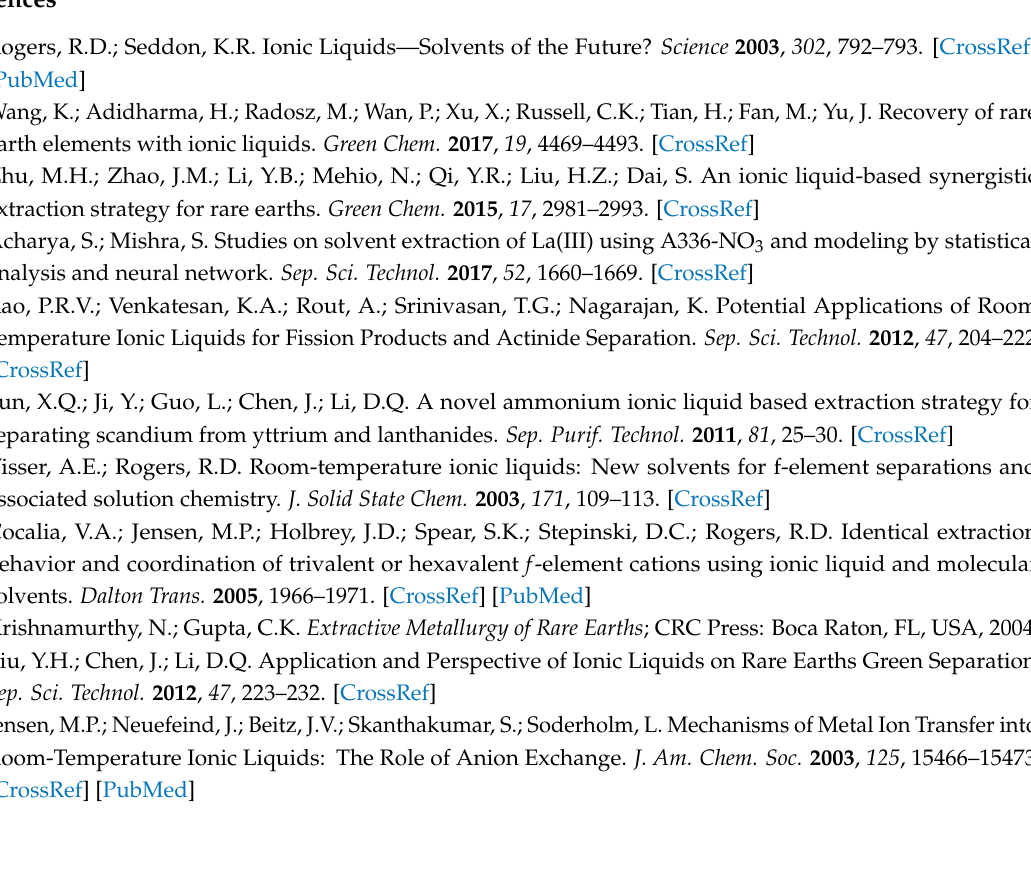
Figure S1: Slope analysis; Figure S2: Back extraction (stripping) studies of La, Nd and Dy; Figure S3: La and Dy negative ion ESI-MS; Figure S4: Variable temperature 139 La NMR spectra; Figure S5: Computational outputs; Figure S6: Infrared spectra; Table S1: Distribution